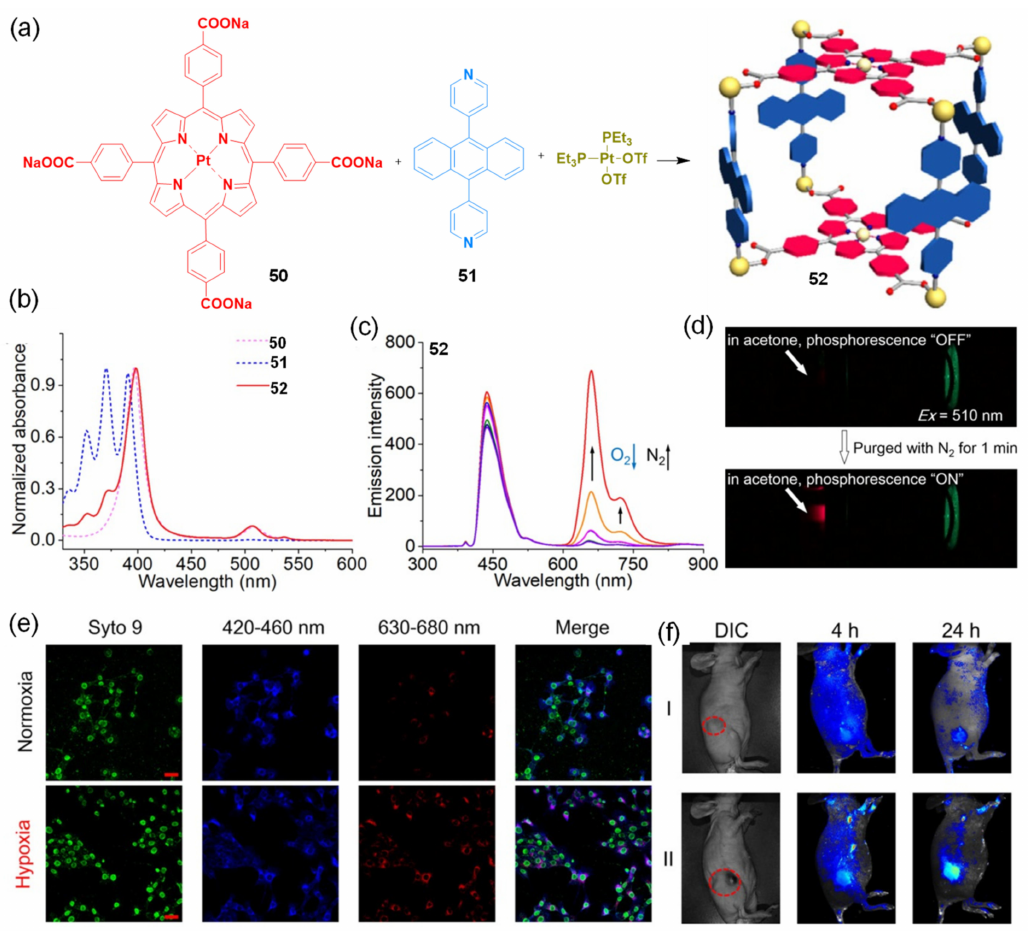
Figure 12. Dual-emissive Pt(II) metallacage and properties. ( a ) Synthesis of metallacage 52 . ( b ) Nor- malized absorption spectra of 50 , 51 , and 52 . ( c ) Emission spectra of 52 excited at 390 nm under O 2 or N 2 condition. ( d ) Photos of the emissions of an acetone solution of 52 in a quartz cuvette. ( e ) Confocal laser scanning microscopy of 4T1 cells stained by Syto 9 and the metallacage loaded nanoparticles. ( f ) In vivo fluorescent images. Reprinted with permission from Ref. [97]. Copyright 2020 John Wiley and